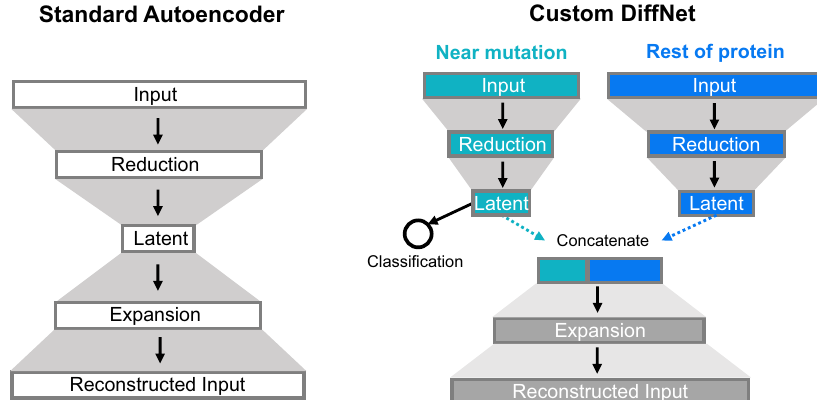
Fig. 1 Standard autoencoder architecture (left) and an example DiffNet architecture (right). Autoencoders have an encoder that compress the input data to a bottleneck, or latent, layer and a decoder that expands the latent representation to reconstruct the original input. The DiffNet adds a classi fi cation task to the latent space. In the example shown, the input is split into two encoders. One is a supervised encoder that operates on atoms near the mutation (cyan) and must predict the biochemical property associated with a structure. The second encoder is unsupervised and operates on the rest of the protein (blue). The latent layers from these two encoders are concatenated and trained to reconstruct the